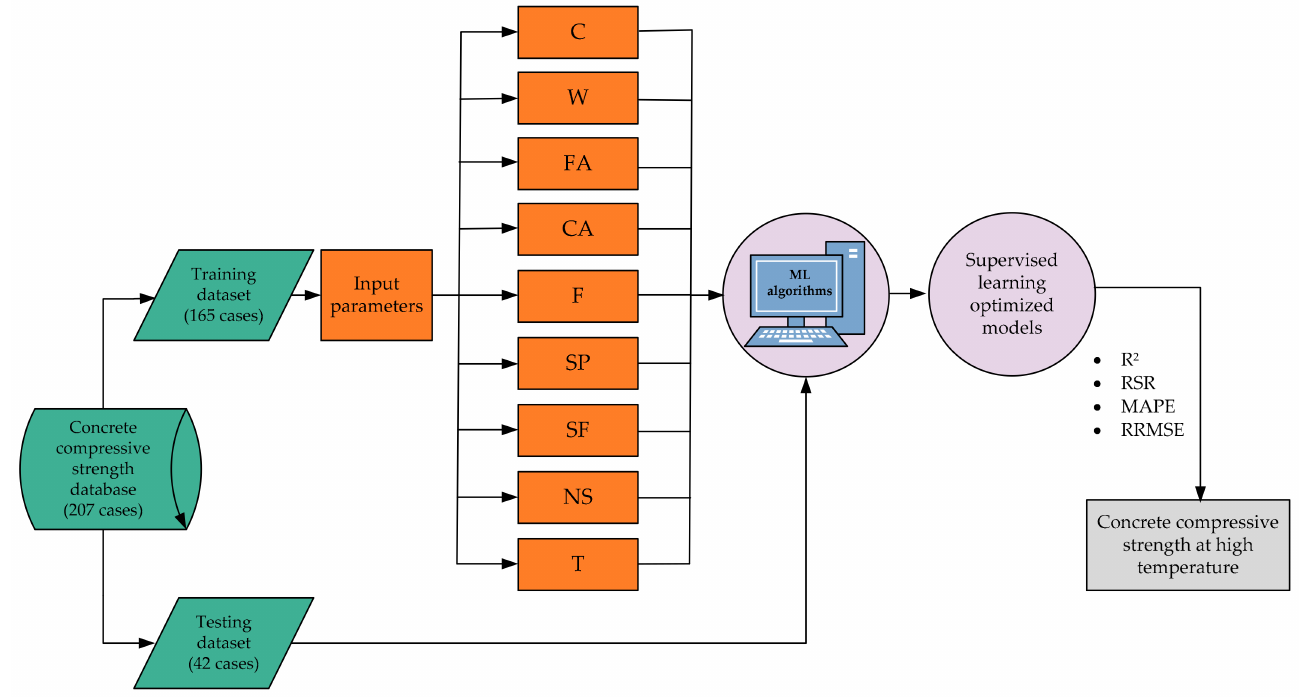
Figure 2. Framework of the proposed